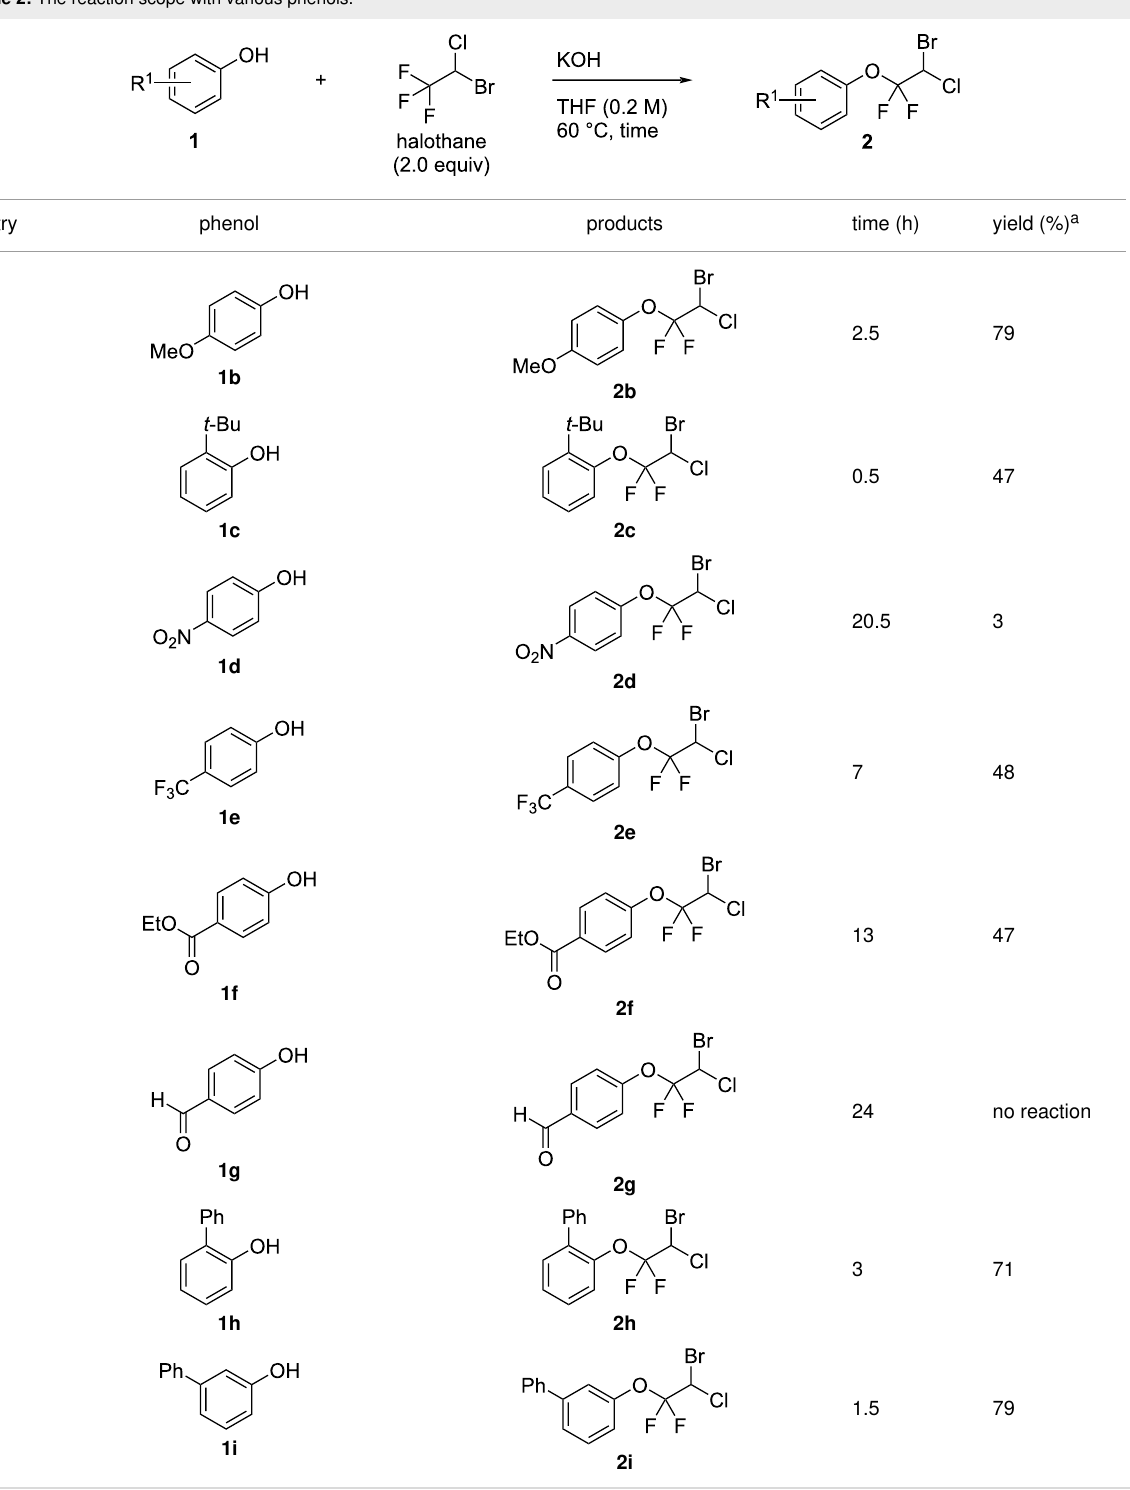
Table 2: The reaction scope with various